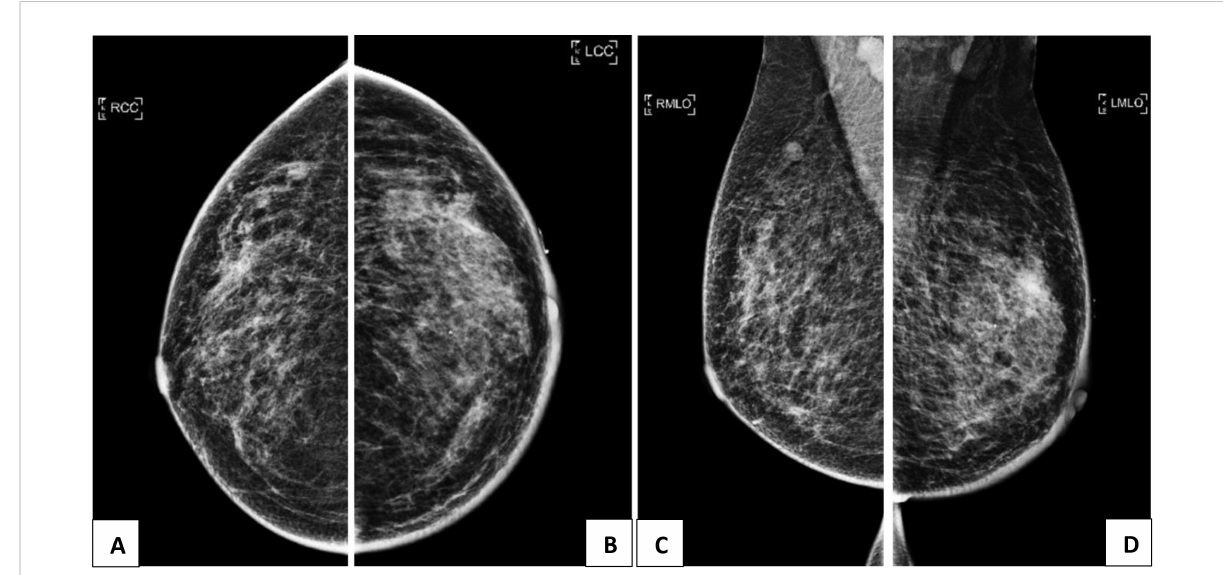
FIGURE 1 (A, C) : Mammogram of the right breast showing an 8 x 8mm partly circumscribed nodule in the right axillary tail, corresponding to the intramammary lymph mode on ultrasound. Abnormal lymph nodes are also seen in bilateral axillae, denser on the right. (B, D) : Mammogram of the left breast showing a vague asymmetric density in the upper outer quadrant, corresponding to the palpable lump. The overlying skin is thickened with slight retraction of the